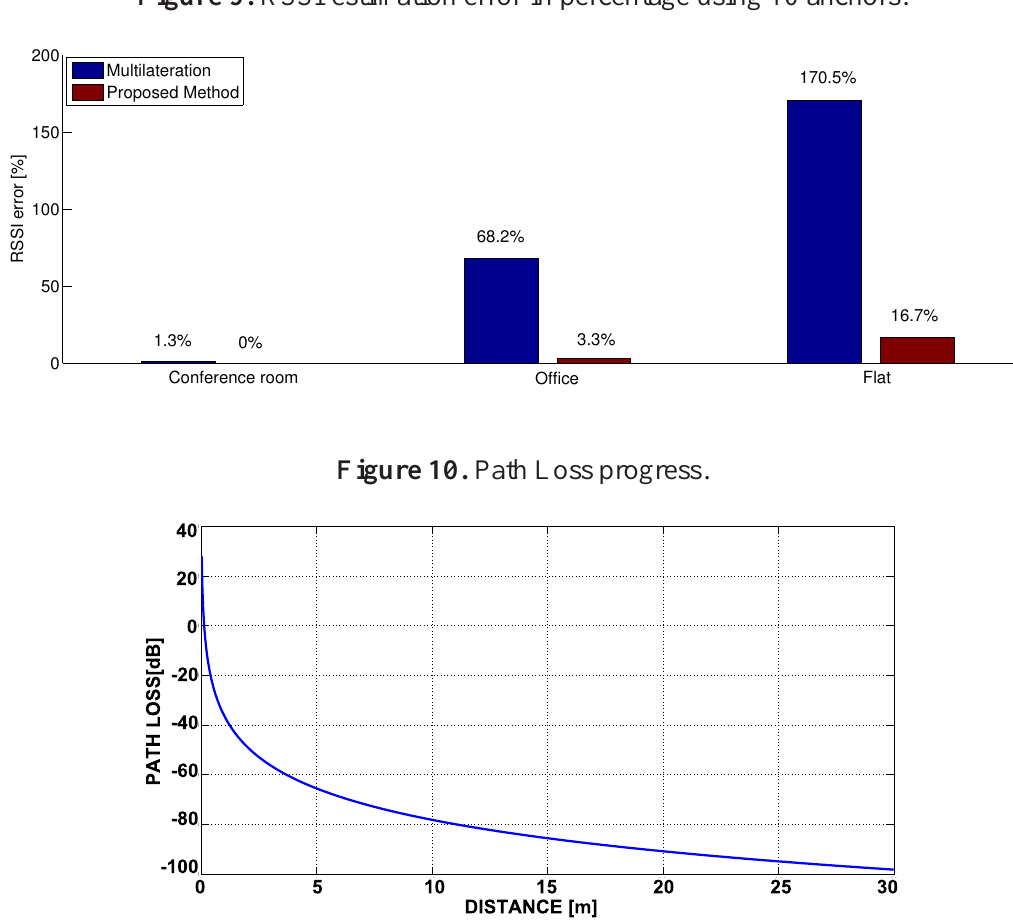
Figure 9. RSSI estimation error in percentage using 10 anchors.